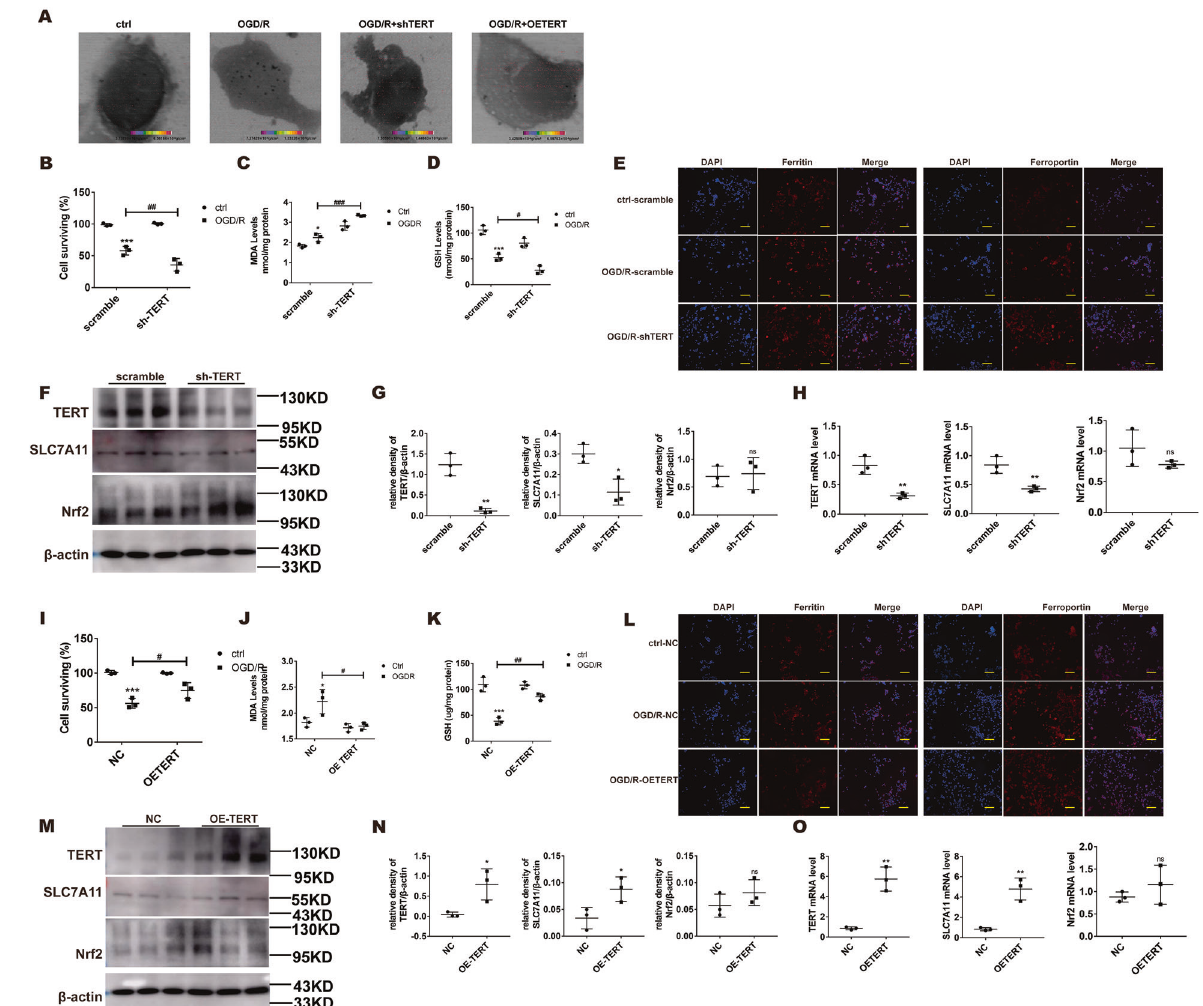
Fig. 6 Low TERT levels enhance ferroptosis, whereas TERT overexpression (OETERT) alleviates ferroptosis via upregulating SLC7A11. A Fe distribution and content. B , I Evaluation of cell viability after OGD/R, as evidenced by CCK8 assay. C , J MDA levels after OGD/R, as assessed by MDA assay. D , K GSH levels after OGD/R, as assessed by GSH assay. E , L Evaluation of ferritin and ferroportin (red), using immunohistochemistry. Nuclear staining done with DAPI (blue) after OGD/R. Scale bar: 100 μ m. F , M Evaluation of Nrf2 and its potential downstream proteins via western blotting under different treatment conditions. G , N Protein quanti fi cation. H , O mRNA levels of the examined factors. Error bars denote standard error from three individual experiments. Data are expressed as mean ± SEM. * P < 0.05, ** P < 0.01, *** P < 0.001 denotes intergroup signi fi cant difference. *Relative to the sham control mice. # Relative to the OGD/R